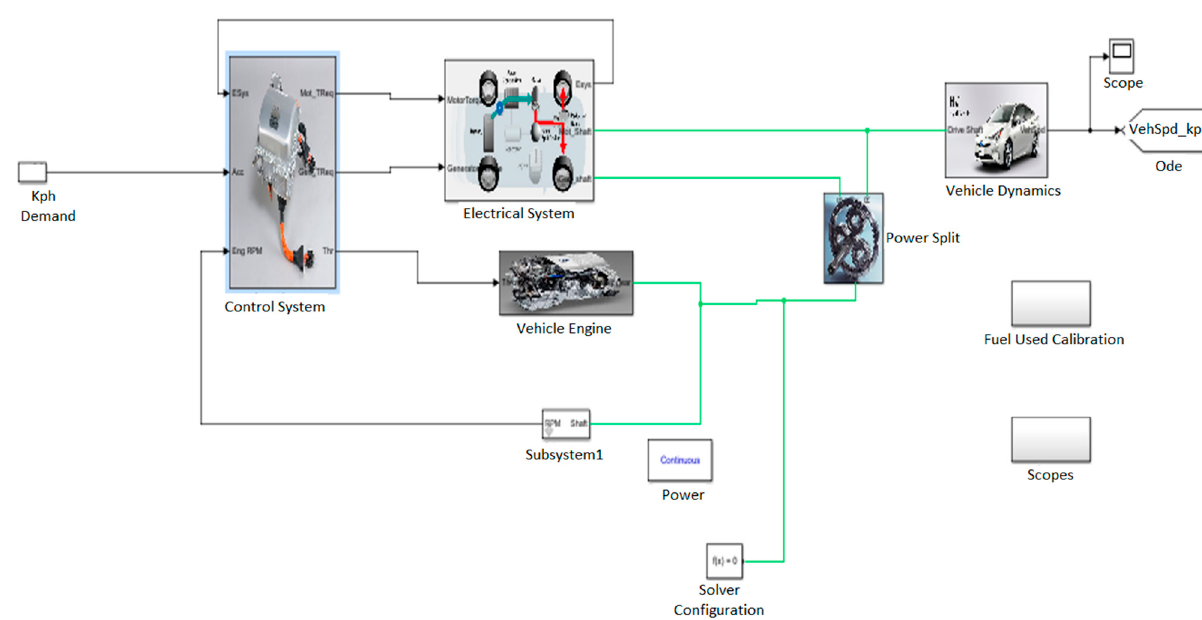
Figure 10. Modelling control system.